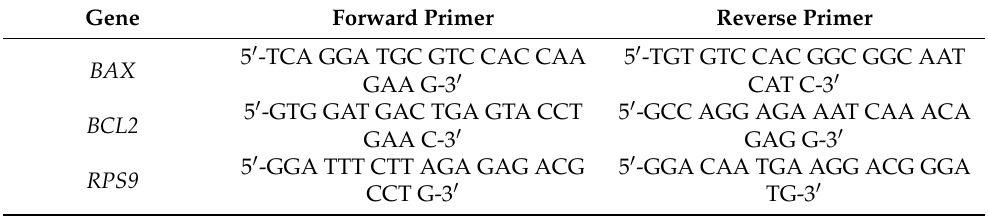
Table 3. Primers used in